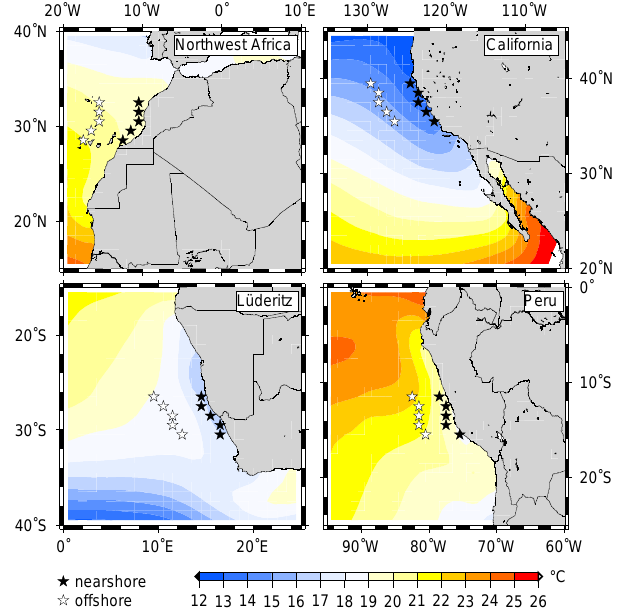
Fig. 1. Coastal (black) and offshore (white) data points for the cal- culation of the SST index from the HadISST dataset for the four major upwelling regions off NW Africa, California, L¨uderitz and Peru. The SST index is the difference between the offshore mean SST and the coastal mean SST. The background is the long-term SST calculated from the HadISST dataset (Rayner et al.,